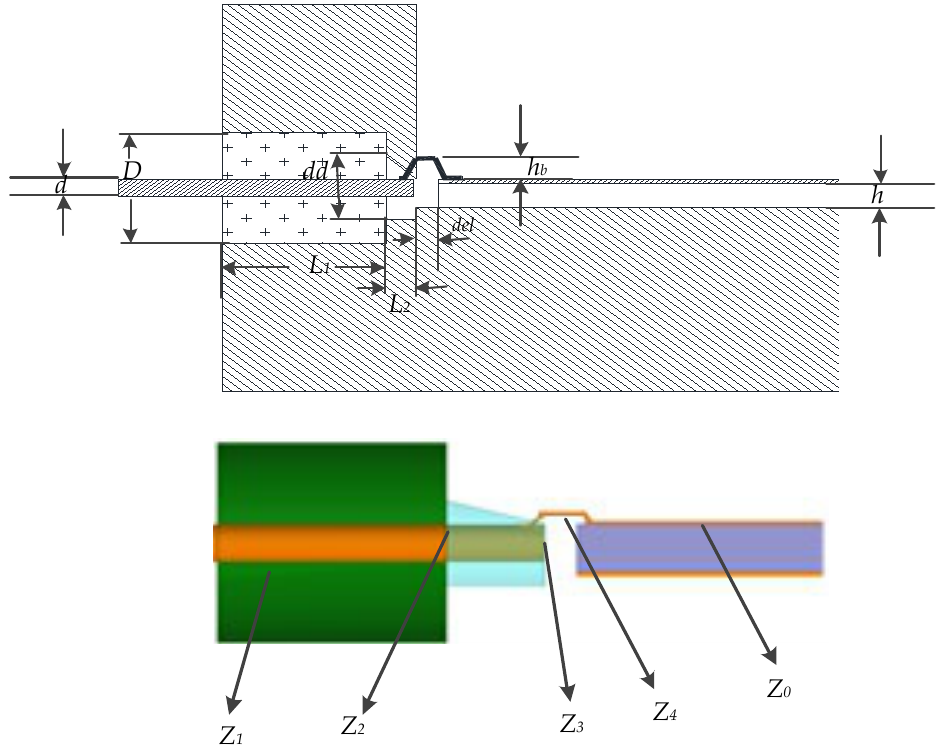
Figure 12. The novel horizontal interconnection structure.